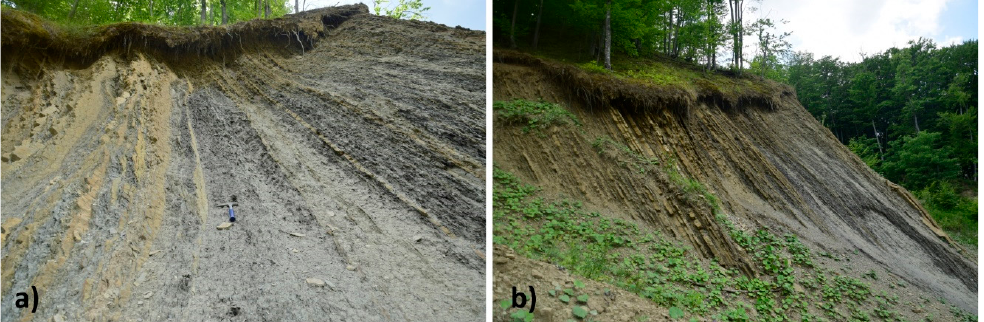
Figure 4. Outcrop in the upper part of the earth fl ow showing the fault zone and the contact between the two geologic formations. The picture was taken on 16 March 2019. Note that a landslide deposit covered the entire outcrop during the survey on 28 June 2020. The numbers indicate dip and dip angle values. The Chirle ș ti earth fl ow’s main source area is about 500 m in length and 50 to 80 m wide. Most of the material is supplied by the regressive erosion of the headscarp. Other scarps are located along the earth fl ow, with two on the left side (Figure 4) and one on the right side (Figure 5). The displacement rate here is very low, so certain areas have become more stable and partially forested.